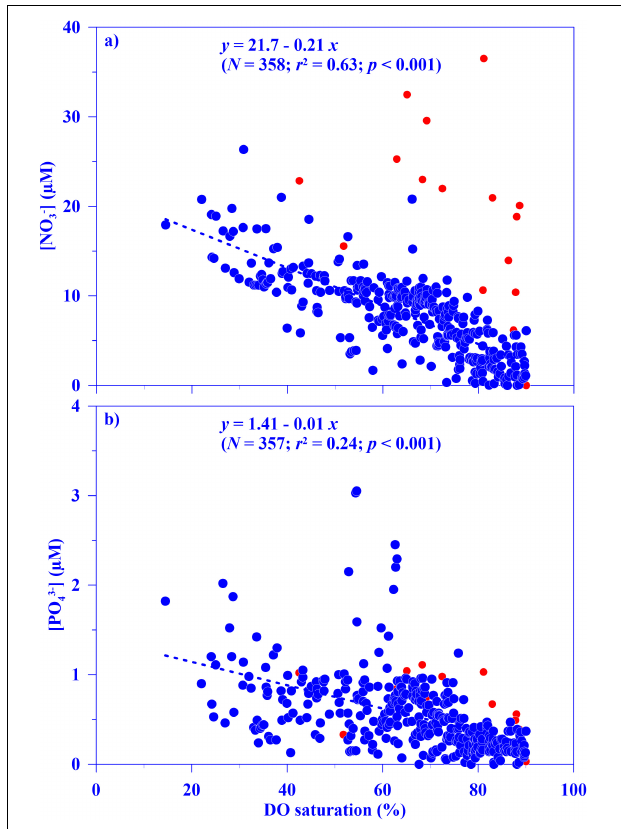
FIGURE 6 | Relationships between dissolved oxygen (DO) saturated rate (%) vs. concentrations ( µ M) of (a) nitrate (NO 3 − ) and (b) phosphate (PO 43 − ) for all pooled data in this study, except for DO rate > 90%. Data marked with red represent salinity < 30. Linear regression is displayed and applies only to the data marked with blue (or salinity ≥